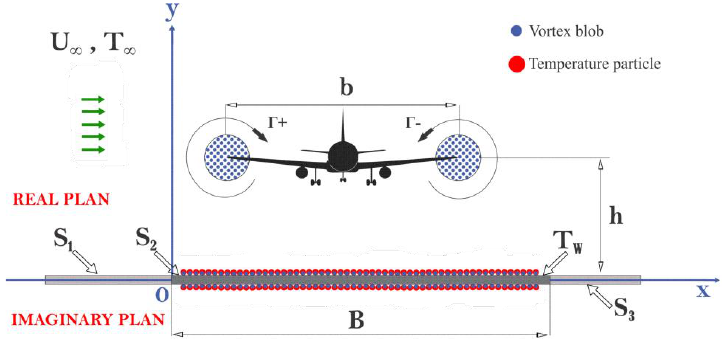
Figure 1. Problem geometry and important definitions.